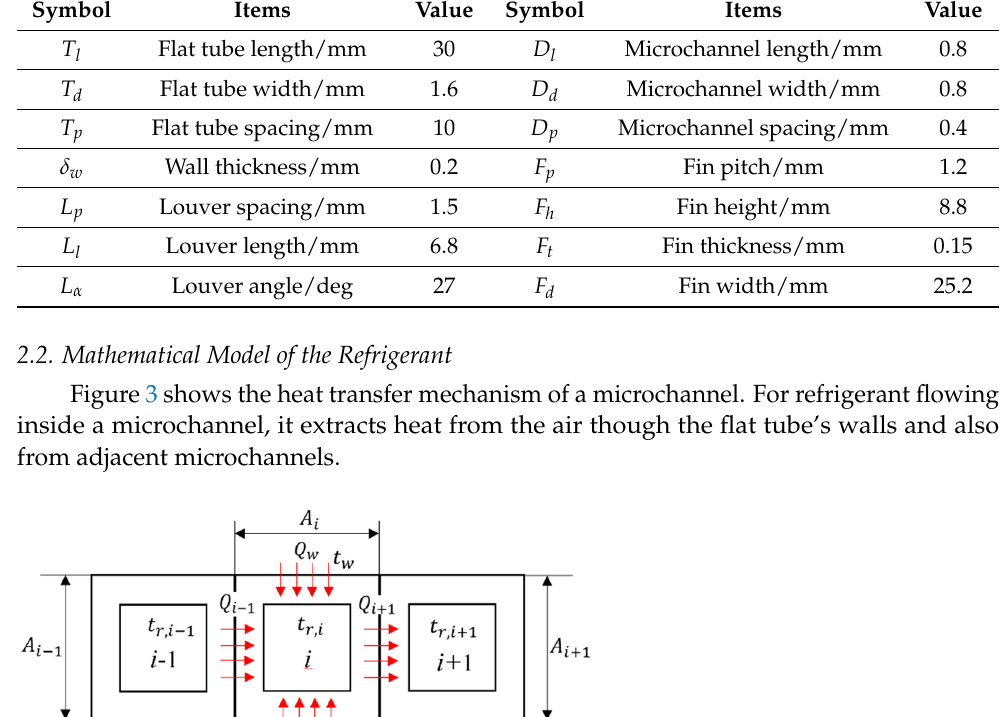
Table 1. Structural parameters of the fins and microchannels of a flat tube. Symbol